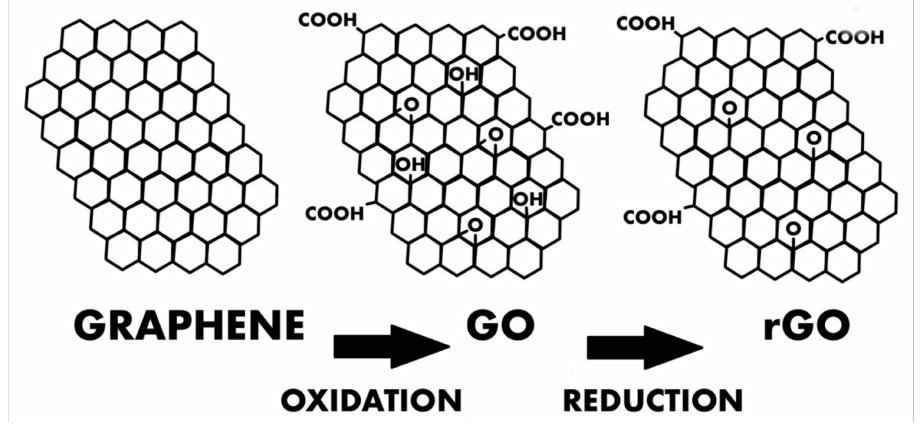
Figure 3. Diagram showing the structure of graphene, GO, and rGO. Qin Tu et al. examined the growth and branching of primary rat hippocampal neurons on coverslips coated with the chemically functionalized GOs with different surface charges on a scaffold. The team reported that the hippocampal neuron grew well on all GOs (GO- COOH, GO-OCH 3 , GO-NH 2 , GO-PABS) and showed that neuron viability was as high as 96% after 7 days of culturing. Neurons displayed a regular morphology and were arranged and spatially configurated in visible complex networks. However, the study showed that by modifying GO with either negatively or positively charged functional groups, it was possible to induce neuronal differentiation followed by cell maturation. Culturing on a positively charged GO-NH2 scaffold was characterized by the longest maximum length, size, and number of neurite branches, and proved to be slightly better for the maturation of these cells (Figure 4), indicating that positively charged graphene oxide is the best for